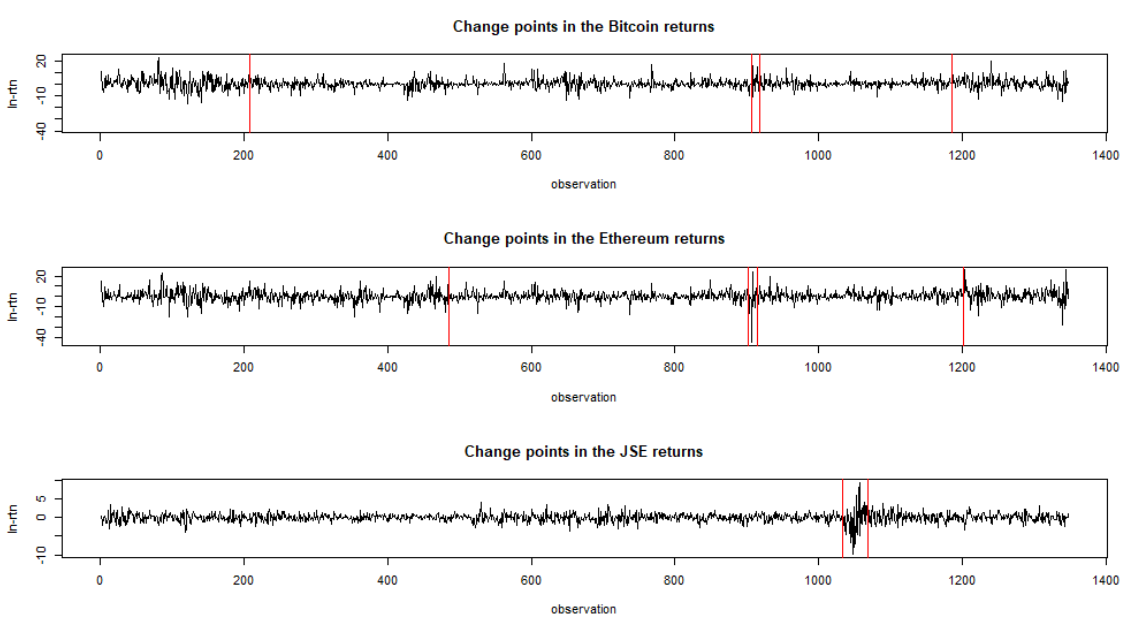
Figure 6. Structural breakpoints as identified by the PELT